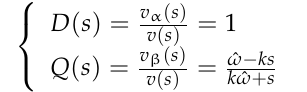
Figure 5. Control block diagram of CCF-MFOF-PLL. Figure 6 shows the control diagram of CCF, whose transfer function can be expressed as: